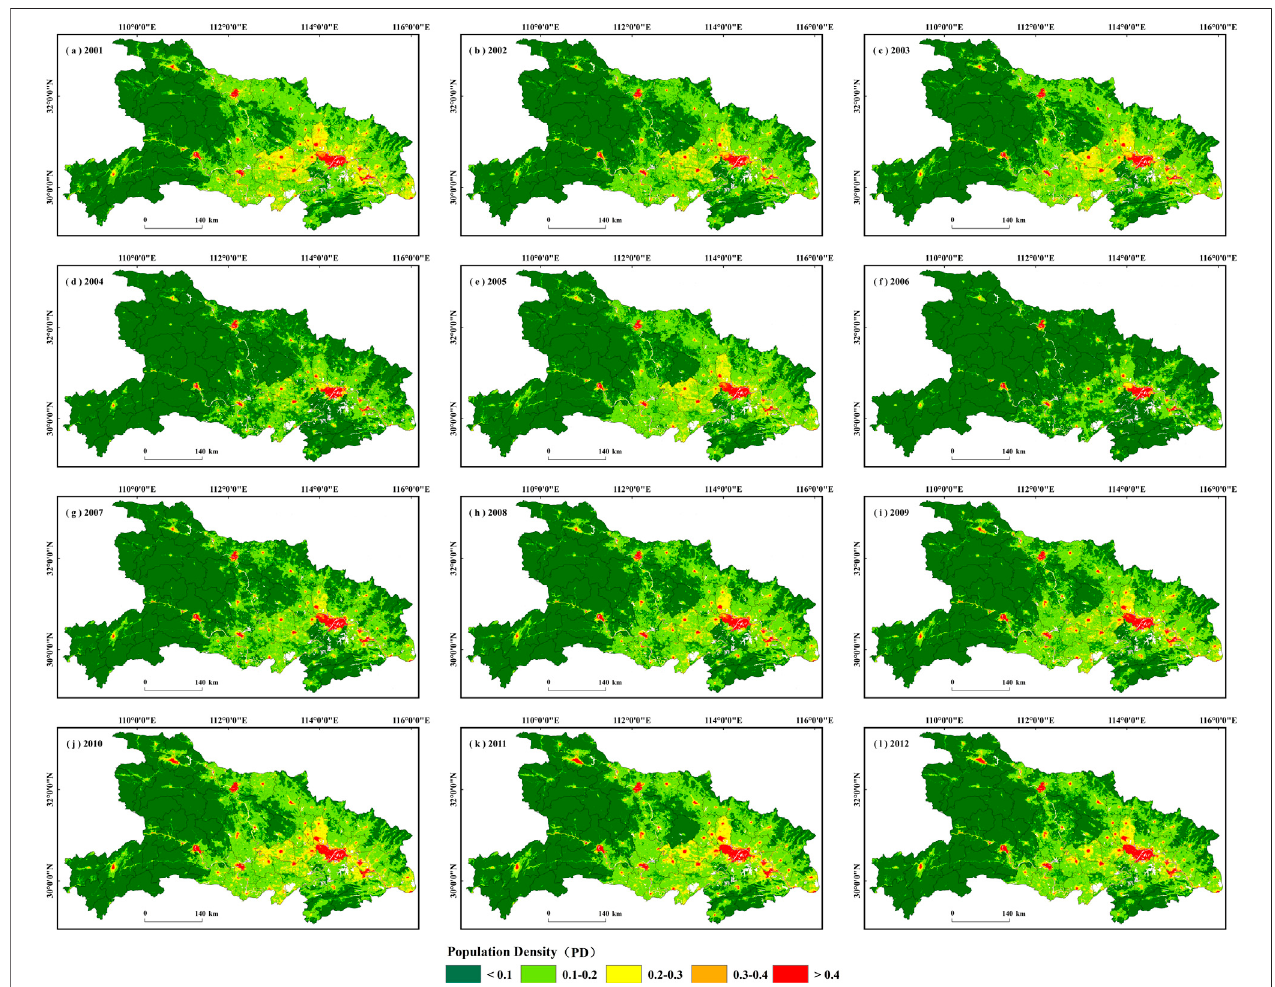
FIGURE 7 | Population density maps with a 250 m × 250 m grid (A) – (L) the different maps from 2001 to 2012.